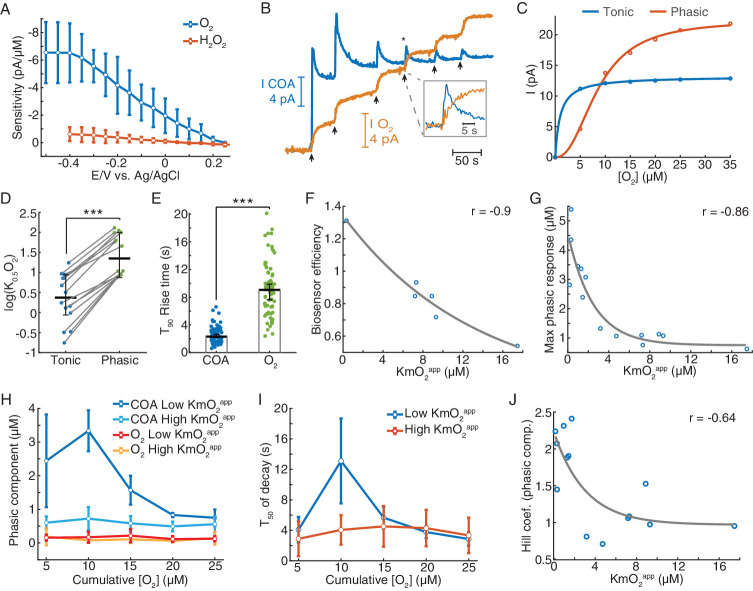
Biosensors generate tonic and phasic COA components in response to O2.(A) The voltammogram shows the DC voltage-related sensitivity of gold-plated sites toward H2O2 (n = 10) and O2 (n = 5). (B) An example of an in vitro O2 calibration. Upon removal of O2 from PBS containing 5 μM Ch, 5 μM O2 additions (arrows) were performed until the tonic sensor response saturated. (C) Representative cumulative tonic and phasic responses as a function of O2 baseline after each addition. Tonic data were fitted with Michaelis-Menten equation, resulting in a KmO2app of 0.97 μM (CI = 0.818–1.126 μM) and Imax = 13.2 pA (CI = 13.04–13.37 pA), with RMSE = 0.08 pA. Phasic responses were fitted to the Hill equation, yielding K0.5O2 = 8.6 μM (CI = 7.58–9.62 μM), Hill coefficient n = 2.31 (CI = 1.74–2.88) and Imax = 22.4 pA (CI = 20.6–24.1), with rmse = 0.50 pA. (D) K0.5O2app values of tonic and phasic components from all biosensors (n = 14). Averages and error bars are medians and CIs. Groups were significantly different (sign test, p<0.0005). (E) T90 rise times of O2 steps and COA peaks following O2 additions (n = 72–95). Bars and error bars represent medians and 95% CIs, groups were significantly different (p<0.0001, Wilcoxon rank sum test). (F) Biosensor efficiency (Ch/H2O2 sensitivity ratio) as a function of KmO2app (n = 6). For illustrative purposes, data were fitted with an exponential function. Spearman correlation between variables was −0.9 (p=0.028). (G) Maximal phasic response to O2 (from each biosensor calibration) as a function of KmO2app (n = 14, rspearman = −0.86, p<0.0001). Data were fitted with an exponential decay curve (decay constant k = 0.4 μM−1, CI = 0.031–0.78 μM−1, rmse = 0.68 μM). (H) Amplitudes of phasic ChOx responses divided into low and high-KmO2app groups (n = 7 per group) following O2 additions. Control phasic O2 using the same algorithm is plotted for the same groups (n = 6 for high-KmO2app and n = 4 for low-KmO2app). Low-KmO2app COA transients were higher than those from the high-KmO2app group (p<0.0001) and the amplitudes from both COA groups were higher than any O2 group (p<0.005). Oxygen transients from low-KmO2app vs. high-KmO2app groups did not significantly differ (p=0.998). Group comparisons by two-way ANOVA for unbalanced data followed by Tukey-Kramer post-hoc tests. Data are means ± CI. (I) T50 decay of transients from low- and high-KmO2app groups as a function of cumulative O2. The decay of peaks at 10 μM O2 was the longest (p<0.0005, two-way ANOVA for unbalanced data followed by Tukey-Kramer post-hoc tests). Data are means ± CI. (J) Hill coefficient from the fits of cumulative COA phasic component vs. cumulative O2 (as in C) as a function of KmO2app (n = 14). The two variables negatively correlate (rspearman = −0.64, p=0.015), showing an exponential-like relationship (fitted initial amplitude of 1.27 ± 0.75, decay constant of 0.33 ± 0.62 μM−1 and offset of 0.97 ± 0.67). ***p<0.001.